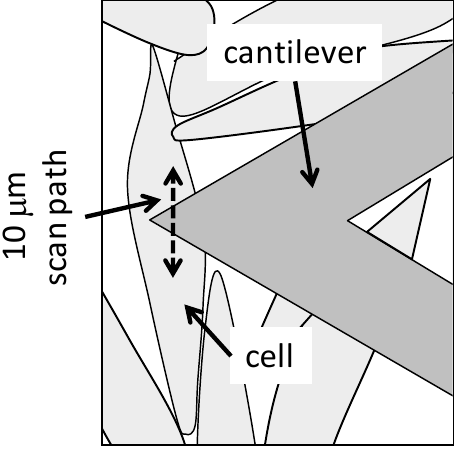
Figure 5. Schematic of the experimental setup. The AFM probe positioned over a single VSMC, with a 10  m reciprocation path along the major axis of the cell. VSMC in the experiment were about 10  m wide and 20–40  m